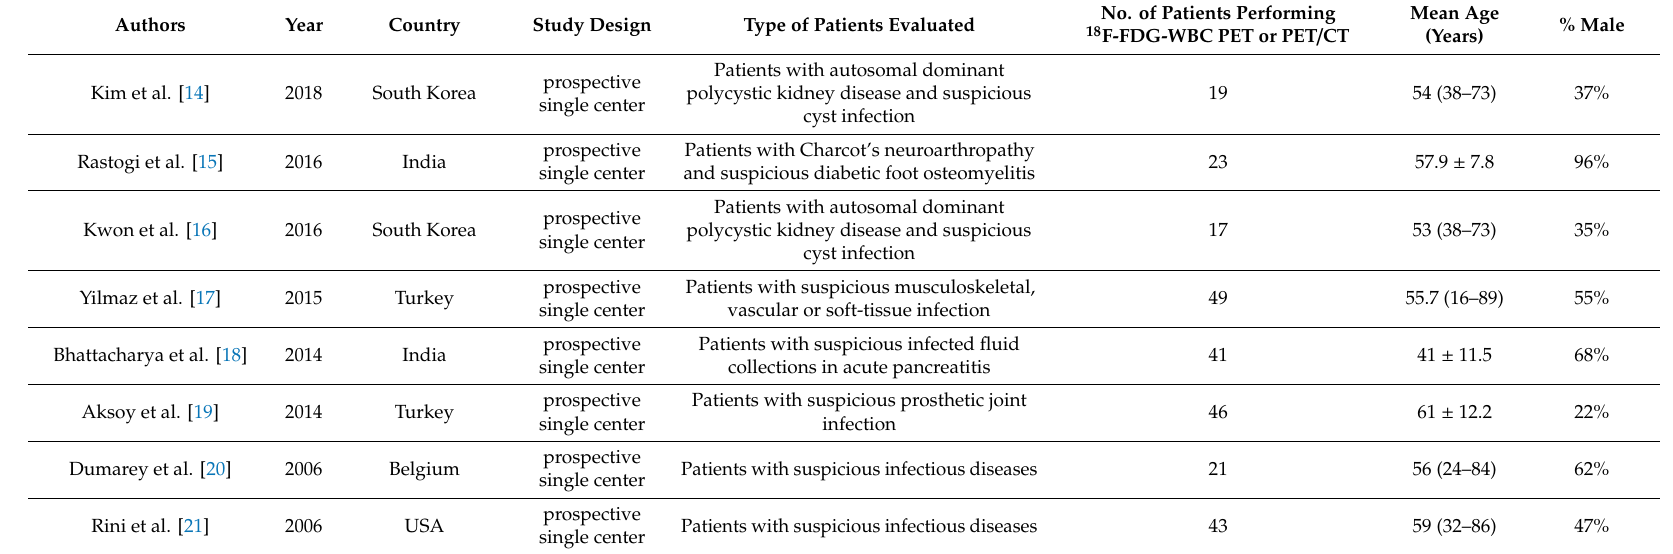
Table 1. Basic study and patient